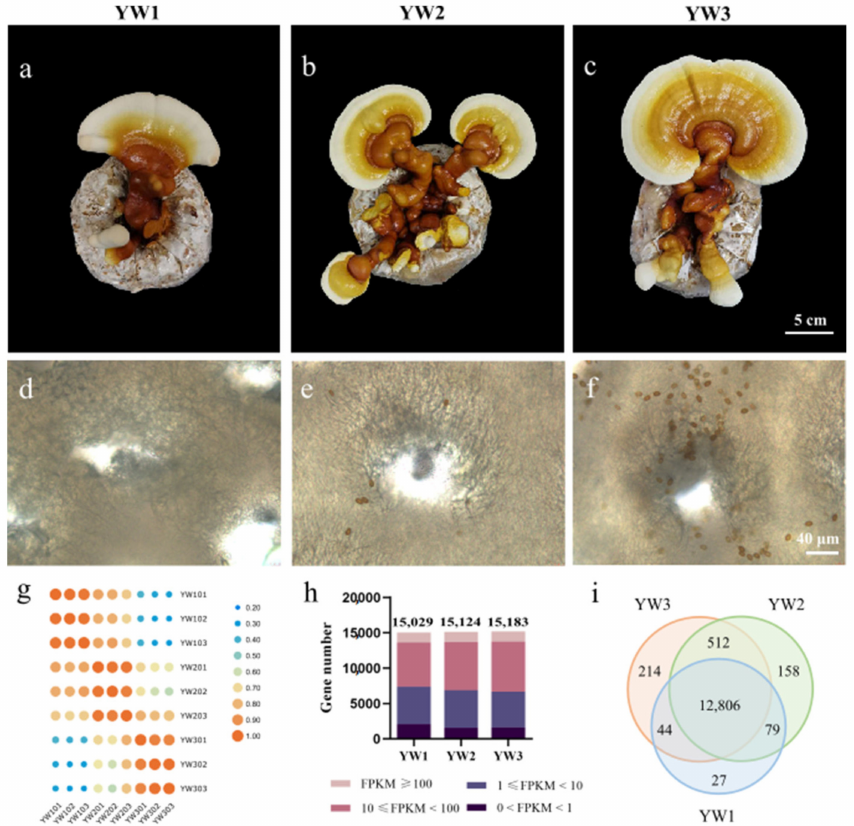
Figure 1. Summary of transcriptome sequence datasets. ( a – f ) Developmental comparisons of pileus ( a – c ) and cross section of gill ( d – f ) at three spore developmental stages of YW-1 strain. Young fruiting body before sporulation ( a , d ), initial stage of sporulation ( b , e ), and nearly mature fruiting body with lots of spores ( c , f ) are referred to as YW1, YW2, and YW3, respectively. ( g ) Correlation among transcriptome datasets. Pearson’s correlation coefficient r was used to assess the reliability of every two RNA sequencing (RNA-Seq) libraries. A score of near 1 between biological replicates indicates faithful replication, while a much lower score between different developmental stages indicates globally different. ( h ) Distribution diagram shows the number of genes with different fragments per kilobase of transcript per million fragments mapped (FPKM) values across the three developmental stages. ( i ) Venn diagram shows the number of stage-specific expressed genes at each developmental stage and the shared expression genes between